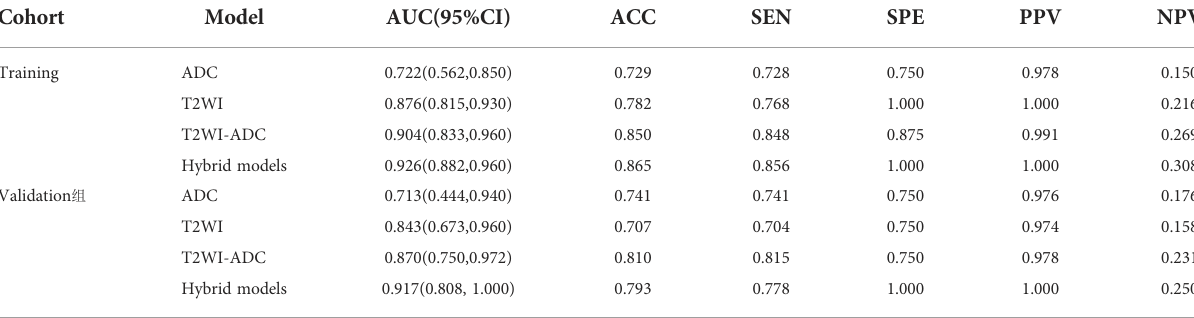
TABLE 3 Predictive performance of T2WI, ADC, T2WI-ADC and hybrid models. Cohort